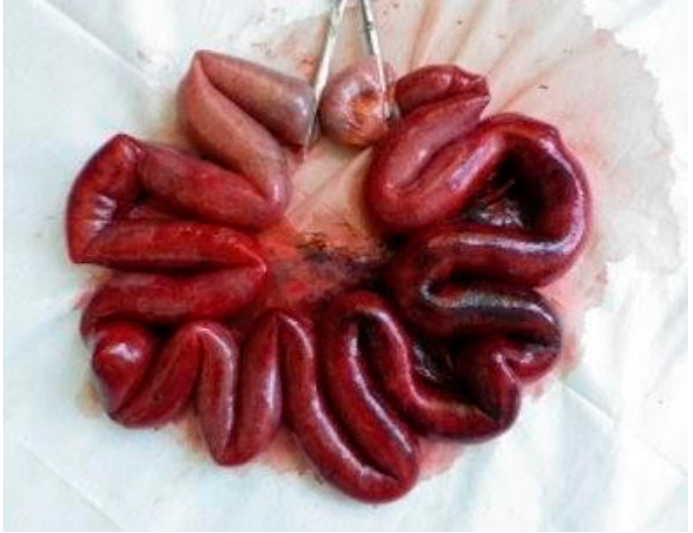
Figure 1. A small intestine of about 2 m 30 cm was removed from the terminal part of the ileum.